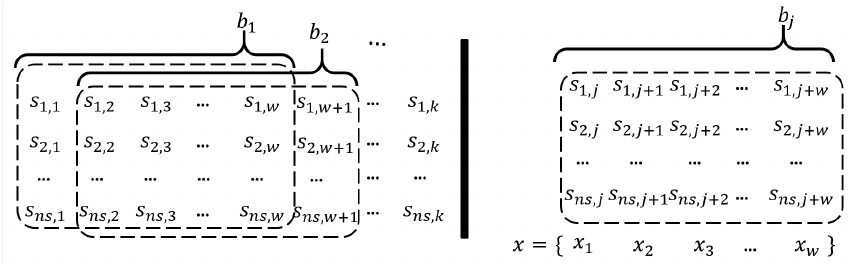
Figure 9. Preparation of input